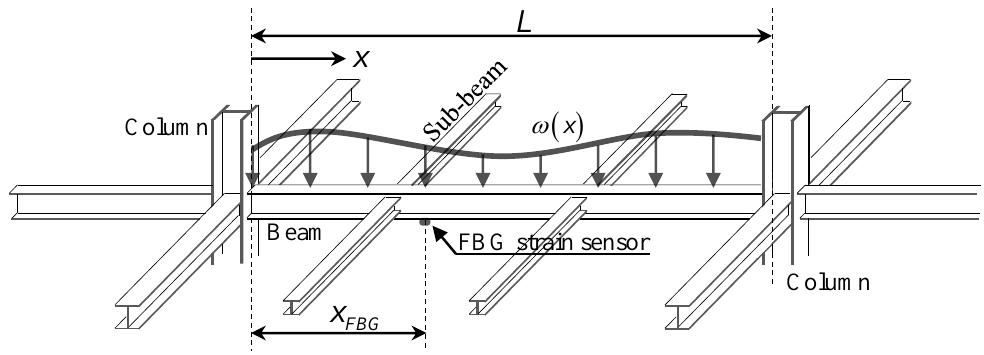
Figure 1. Beam structure subjected to a distributed load and point loads from